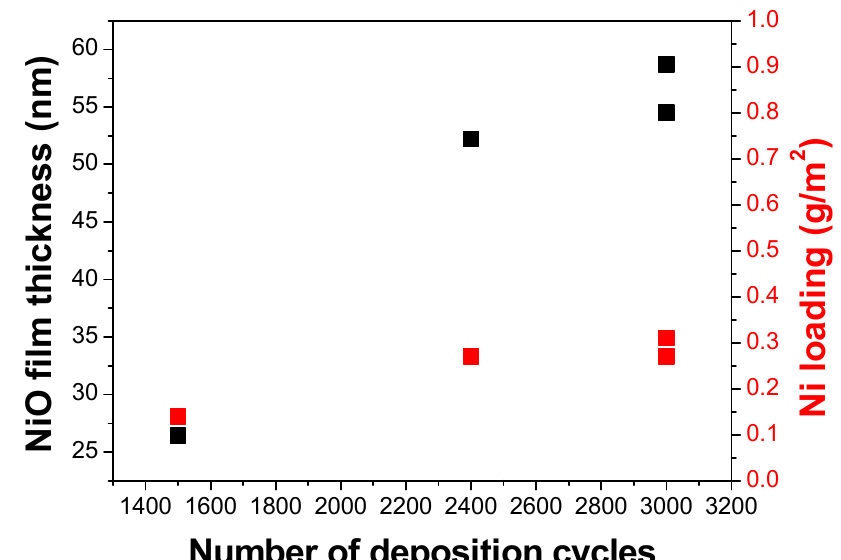
Figure 1. Thickness of NiO on the Si (100) substrate as a function of the number of the deposition cycles. The precursors’ pulse and purge rates are the same. The film thickness was calculated using the X-ray reflectivity (XRR) technique. The Ni loading was calculated from the mass difference of the sample before and after the deposition.